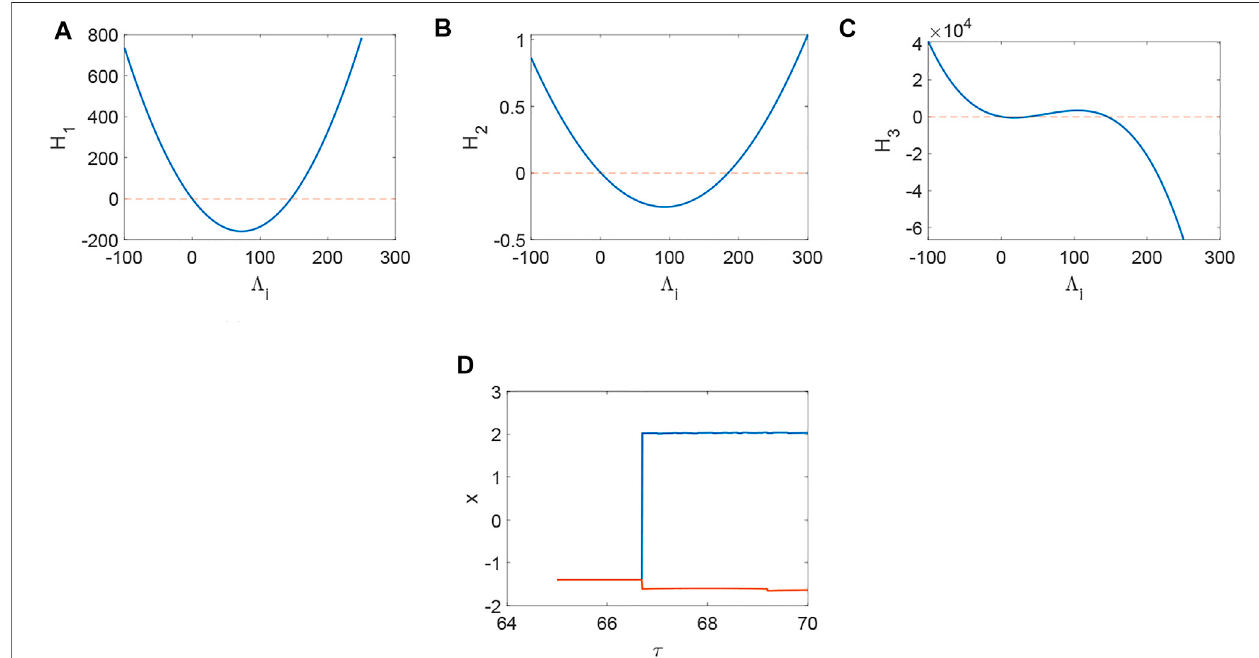
FIGURE1| Thedistribution of H i ( i =1,2,3)when a =1, b =3, c =1, d =5, r =0.01,s=4, I =1, x r = − 1.6, d 1 =0.1, d 2 =0.3, τ =0. (A) Turinginstabilityoccurswhen H 1 < 0,orelsestable. (B) Turinginstabilityoccurswhen H 2 < 0,orelsestable. (C) Turinginstabilityoccurswhen H 3 < 0,orelsestable. (D) Thebifurcationabout τ when d 1 = d 2 = 0.